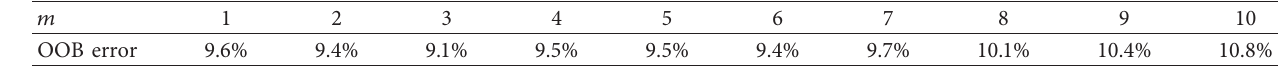
Table 5: OOB errors with different m .